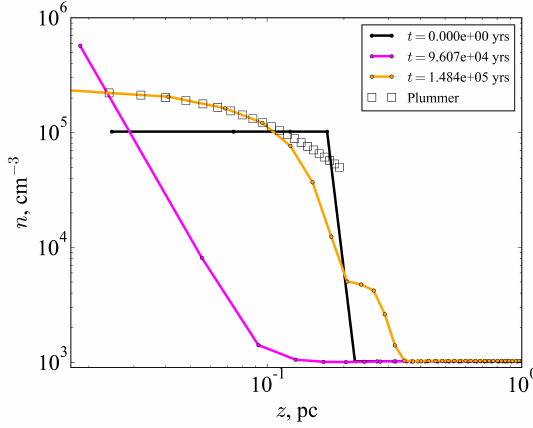
Figure 6. The n ( r = 0, z ) dependences for the adiabatic disk with initially perpendicular magnetic field at t = 0 (black), t = 9.61 × 10 5 yrs (magenta) and t = 1.48 × 10 5 yrs (orange) after the beginning of the collpase. Blanck squares depict a Plummer-like function with power-law exponent p = 2 and height scale 0.1